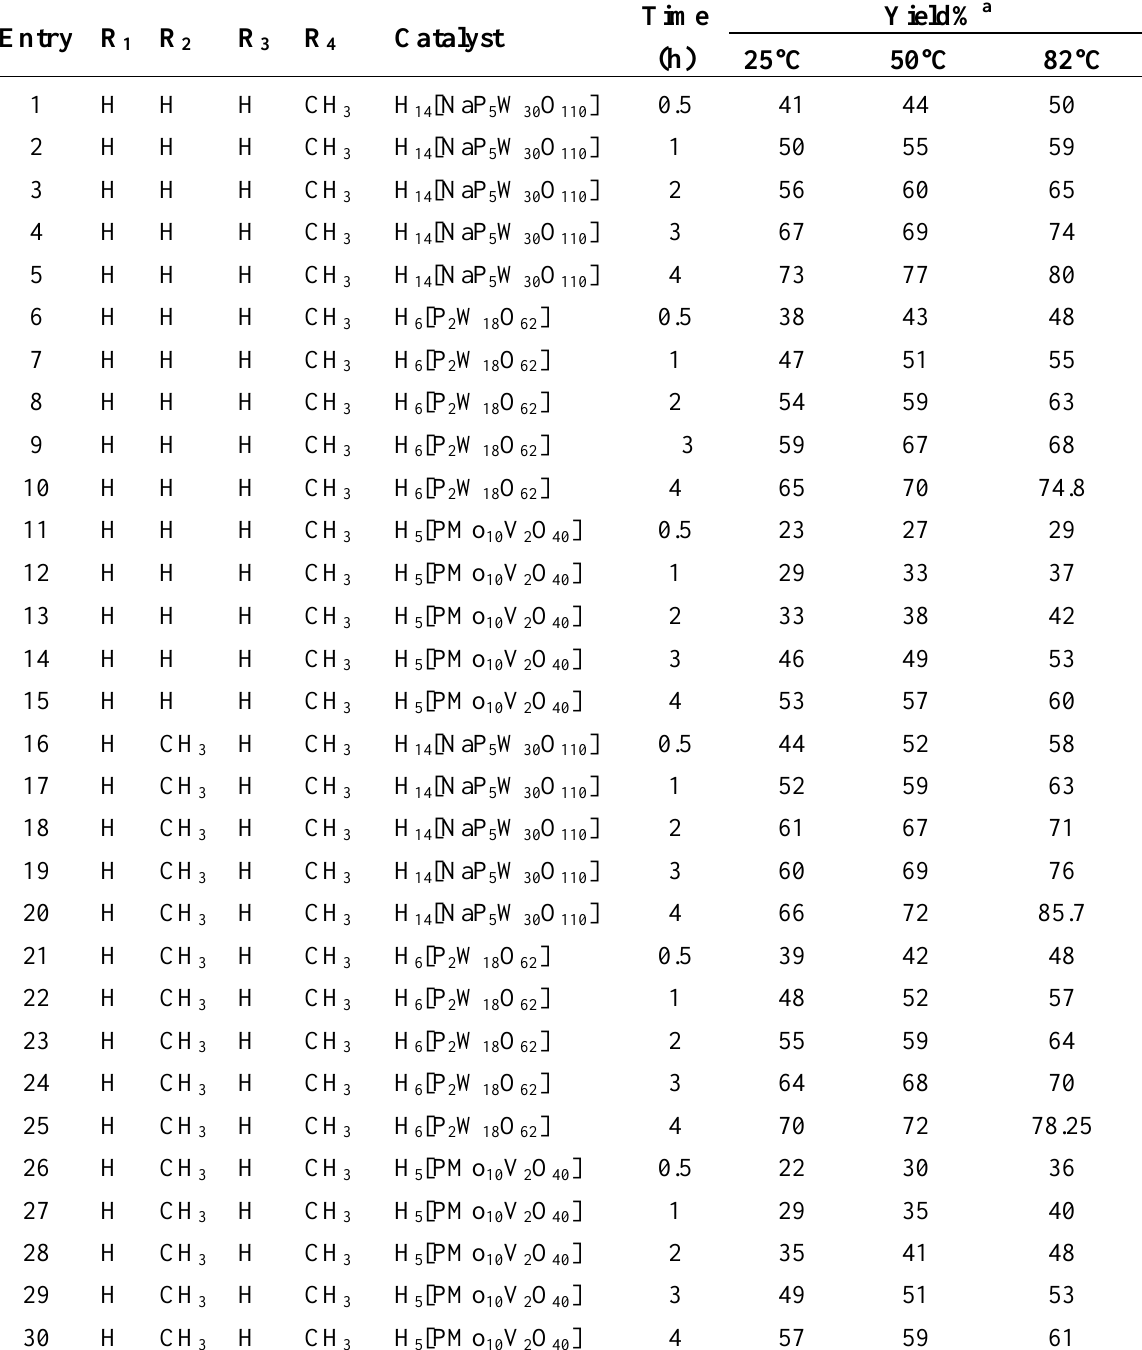
Table 2. Effect of different reaction time and temperature on synthesis of 3,1,5- benzoxadiazepines derivatives using various